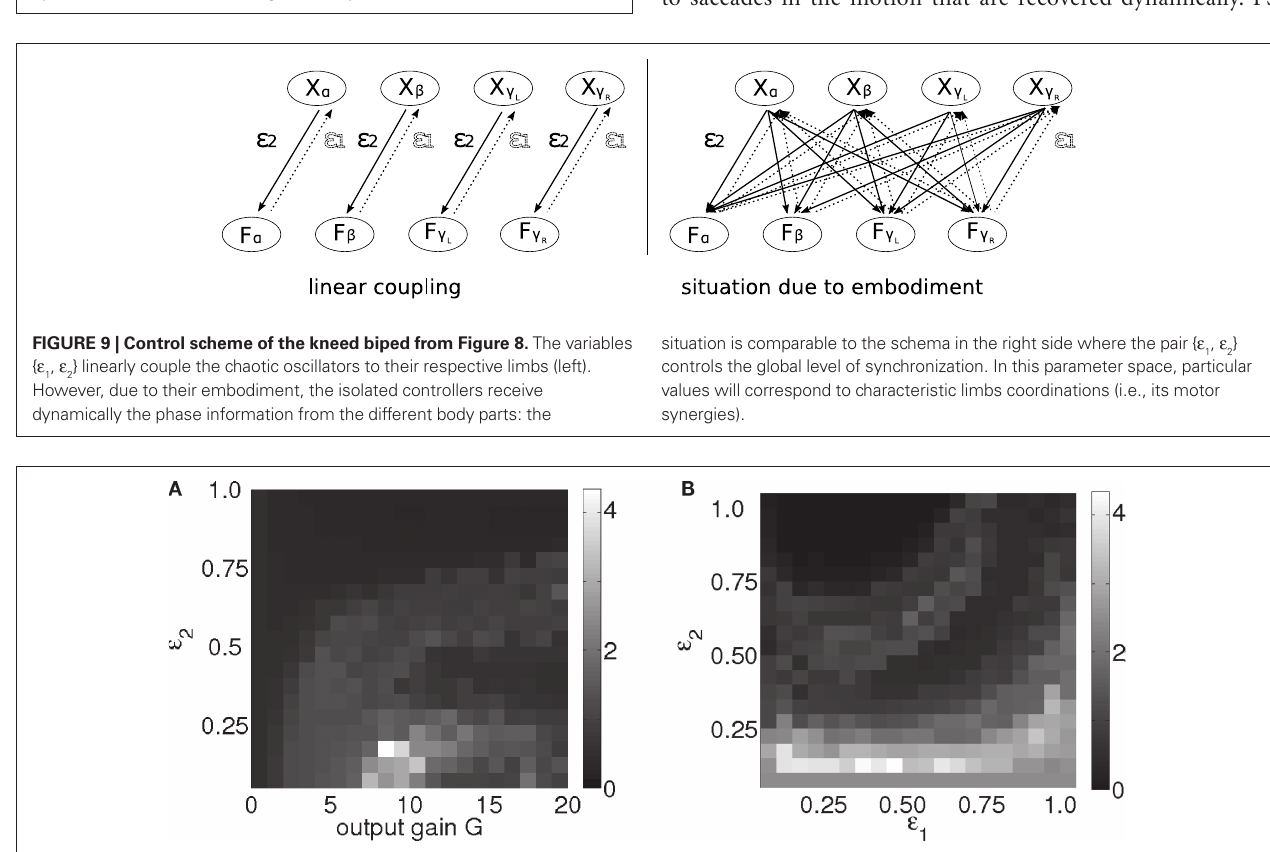
FIGURE 10 | Walking duration performance map for the kneed biped for the particular coupling strengths. These relations correspond to the stable control parameters pair { G , ε } ∈ [0; 1] × [0; 20] in (A) and { ε , ε } ∈ [0; 1] × coordinations occurring between the internal controllers and the biped 2 1 2 [0; 1] in (B). They reveal hidden information structure and correlations for dynamics, its intrinsic behavioral